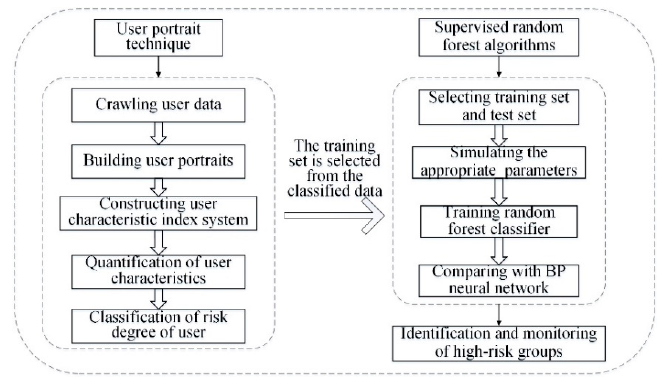
Figure 1. Research framework.